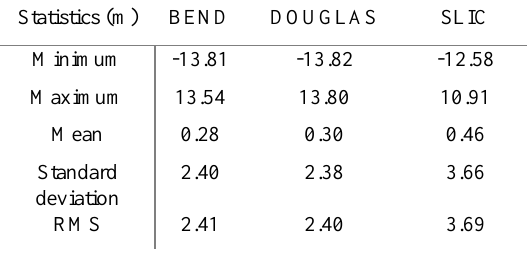
Table 4. Statistics of the